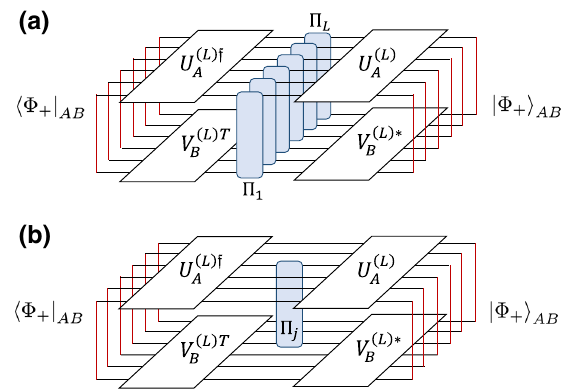
FIG. 2. A schematic picture of the way to compute the global and local cost functions. In each figure, the application of a Bell indicates the taking of contractions on the j th pair | (cid:5) + (cid:4) A j B j pair A j and B j , which we represent by the red solid lines. (a) A schematic picture of Tr[ (cid:7) 1 . . . (cid:7) L ρ AB ( U , V ) ], which gives the global cost function C HST via Eq. (6). (b) A schematic picture of Tr[ (cid:7) j ρ AB ( U , V ) ], which gives the local cost function C LHST via Eq.